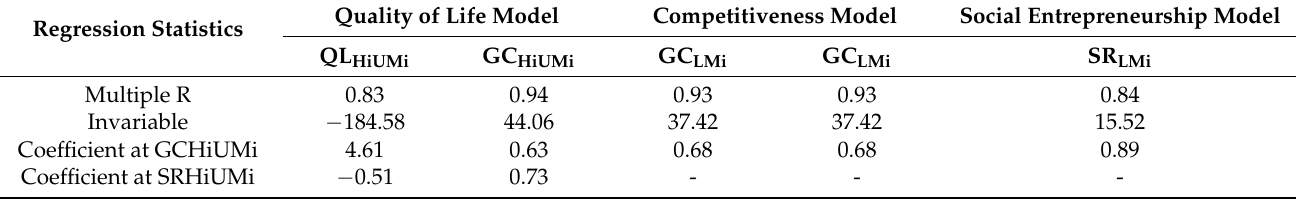
Table 3. Results of the regression